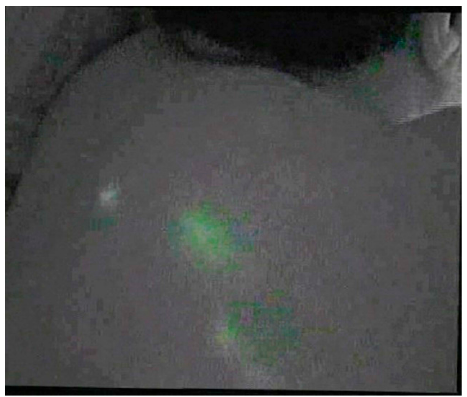
Figure 3. A pathway from the affected axilla to the ipsilateral scapular region.